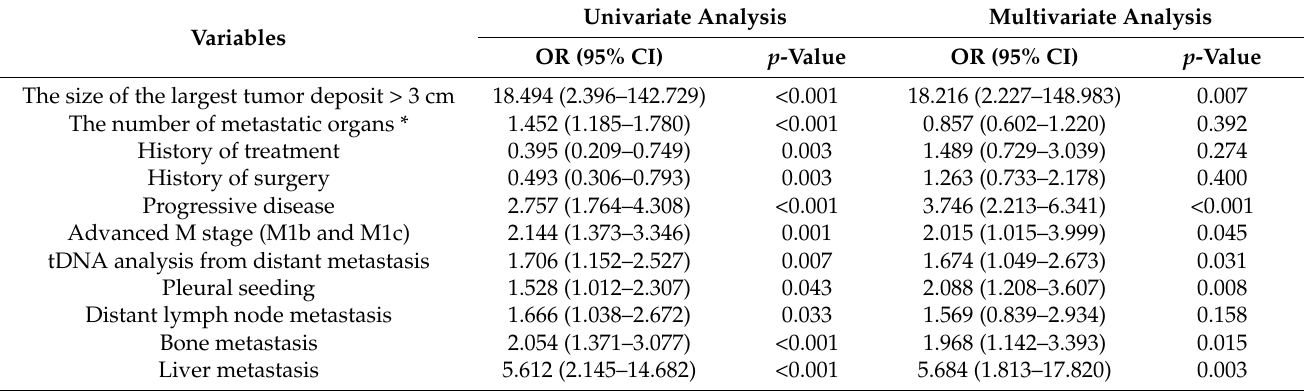
Table 5. Univariate and multivariate analyses of ctDNA and clinicopathological parameters with EGFR mutation detection.